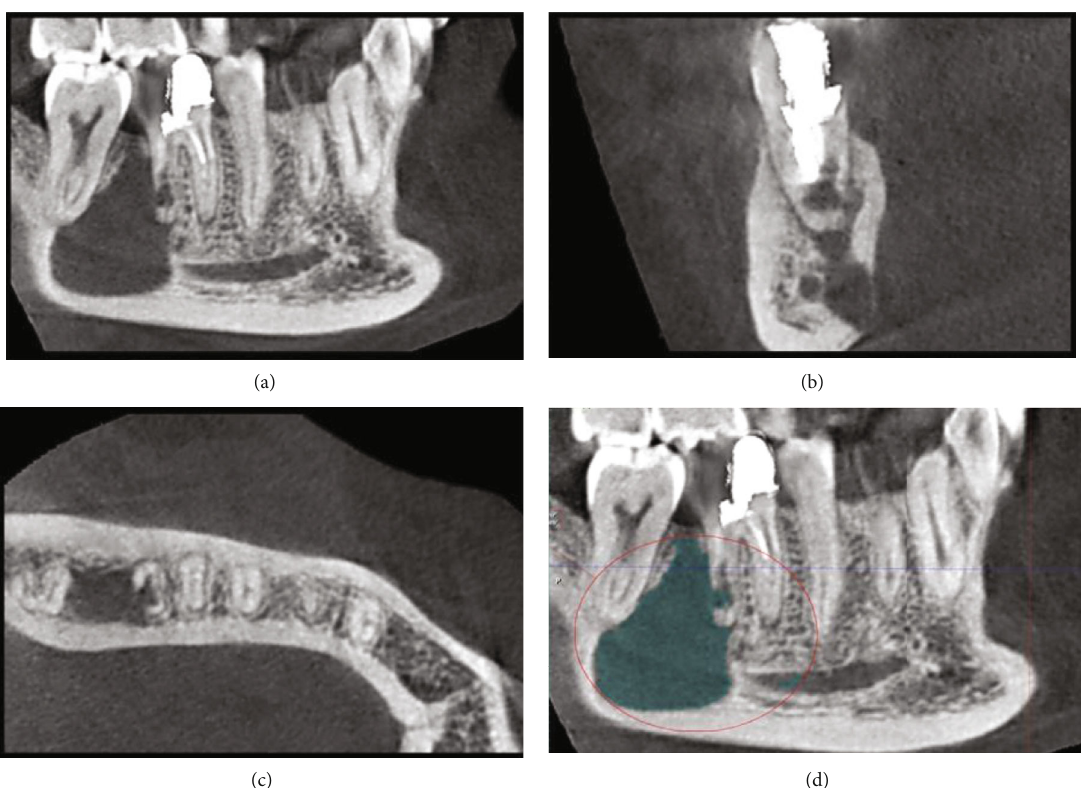
Figure 2: (a) CBCT revealing a well-de fi ned unilocular lesion between the second and fi rst right mandibular molars. (b) Sagittal view showing the expansion of the lesion toward the lingual wall and the consequent thinning of the lingual plate. (c) Axial section showing a perforation in the distal and lingual aspects of the apical third of the distal root of the right fi rst molar. (d) The main osteolytic lesion appears in continuity with the perforation in the distal root of the right mandibular fi rst